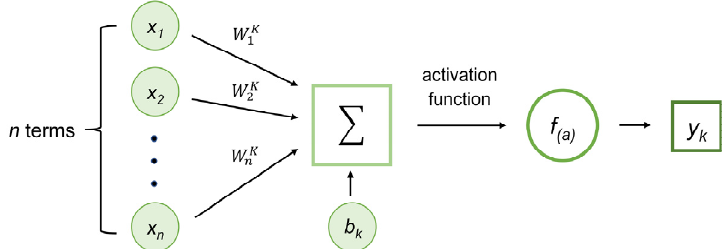
Figure 2. Basic concepts of CNN.